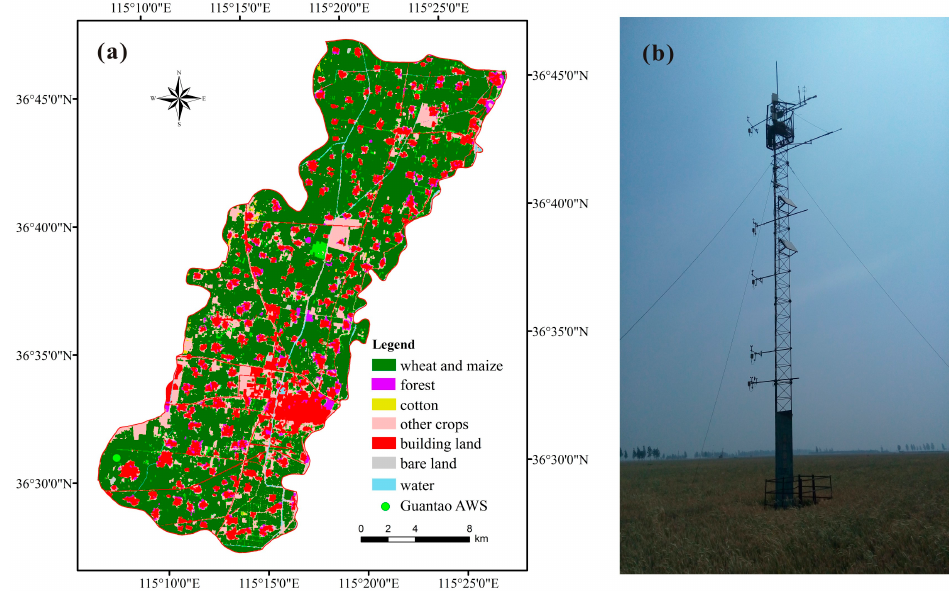
Figure 2. ( a ) Land cover map of Guantao County in 2015; and ( b ) photograph of the AWS tower in Guantao.